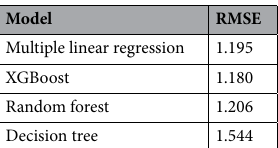
Table 2. Comparison of modeling techniques on root mean square error values. RMSE, root mean square error.